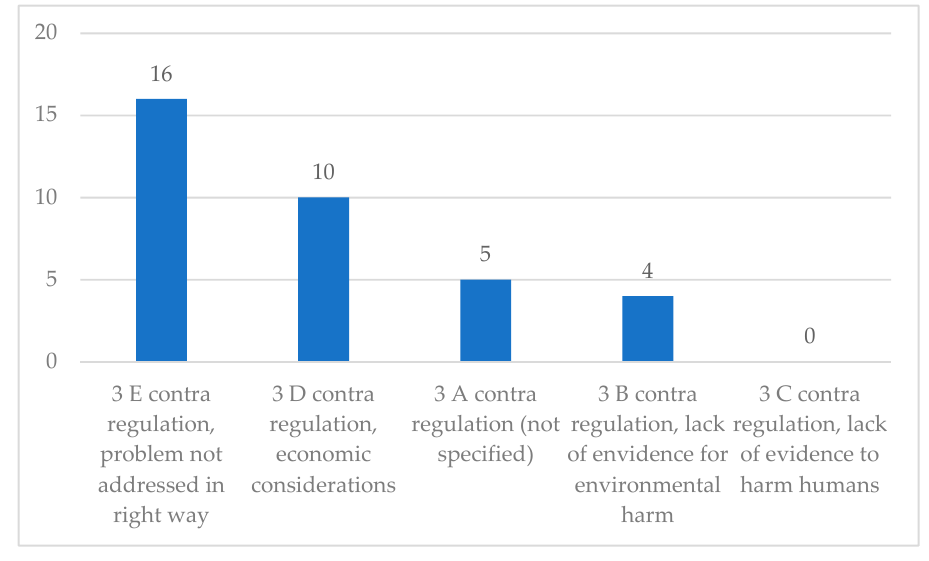
Figure 2. Coding units per sub-category for Category 3 (contra regulation). Table 1. Category frequencies per